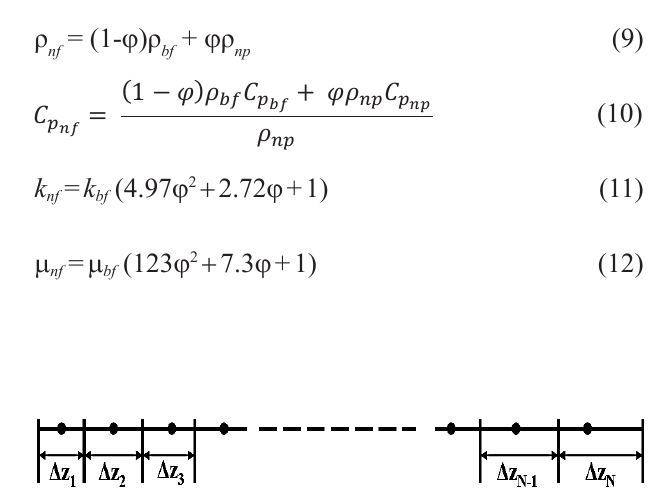
Fig. 2. Parameters of Eq.